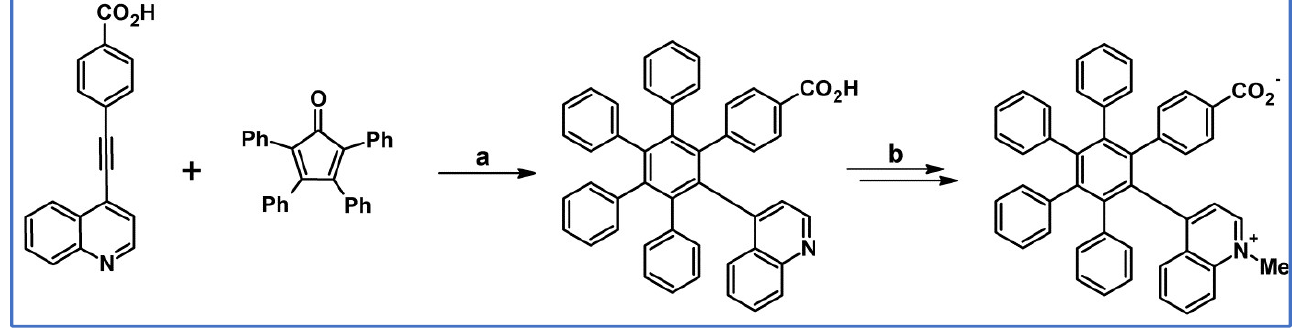
Scheme 146. Synthesis of heterocyclic mesomeric betaine starting from DA cycloaddition with